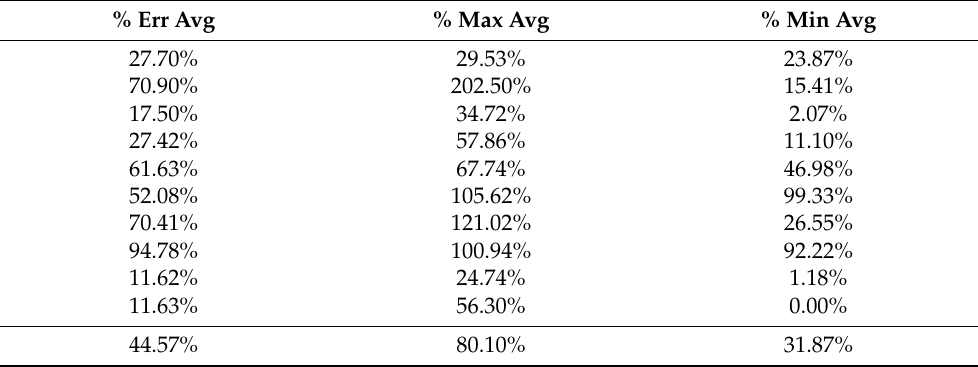
Table A87. Set 2, trials 1–10 data (single 0.5 PR